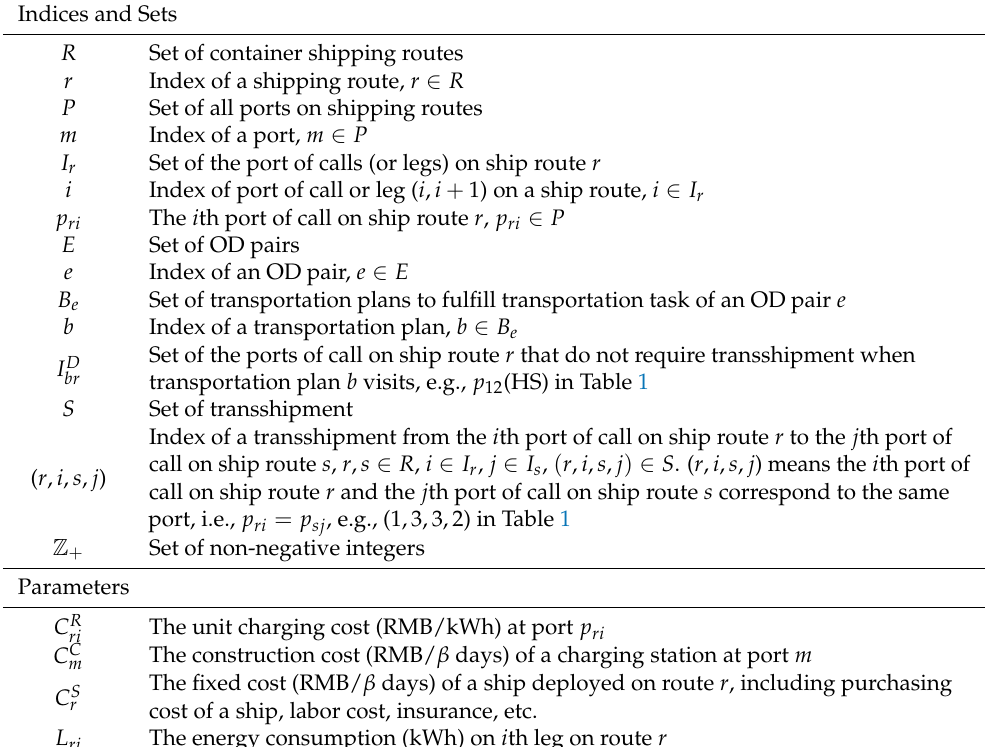
Table 2. Notations used in this